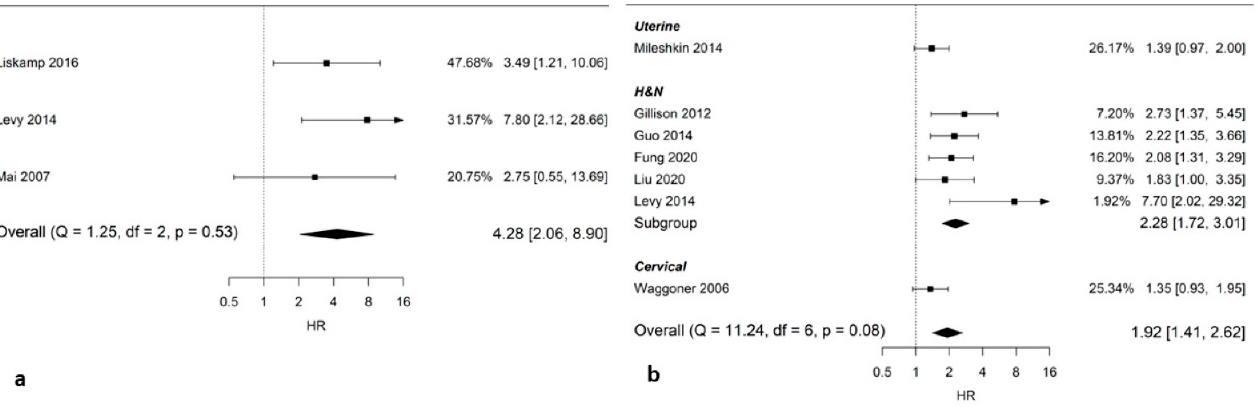
Figure 3. Forest plots on pooled Hazard Ratios (HRs) on smoking during chemoradiotherapy and efficacy. ( a ) Smoking during chemoradiotherapy and locoregional recurrence free survival; ( b ) smoking during chemoradiotherapy and disease-free survival. HR > 1 indicates worse outcome for smokers during radiation treatment, whereas HR < 1 indicates better outcome. Comparison group is non-smoker (former or never). Abbreviation : H&N, head and neck